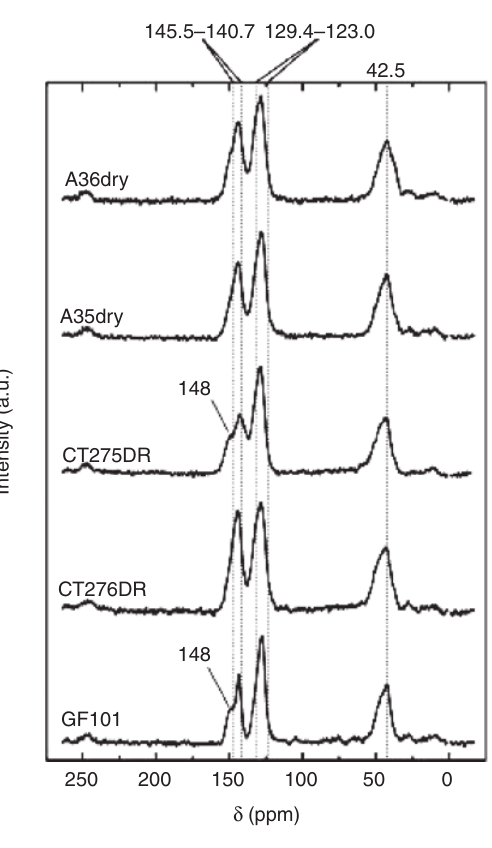
Figure 5: 13 C-NMR spectra of the sulfonic resins with identifying guidelines (detailed in the text and Table